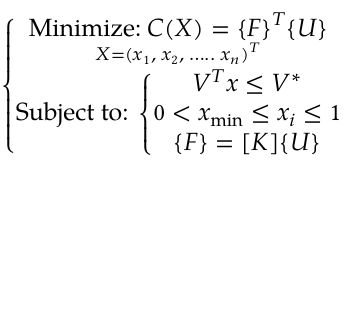
Figure 1: Dimension of the fork end of a knuckle